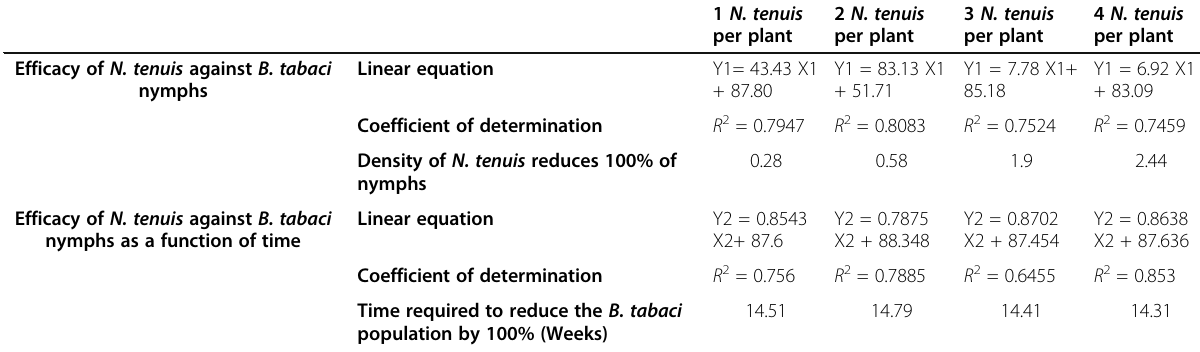
Table 2 Densities of Nesidiocoris tenuis nymphs and periods needed to control the entire population of Bemisia tabaci according to doses